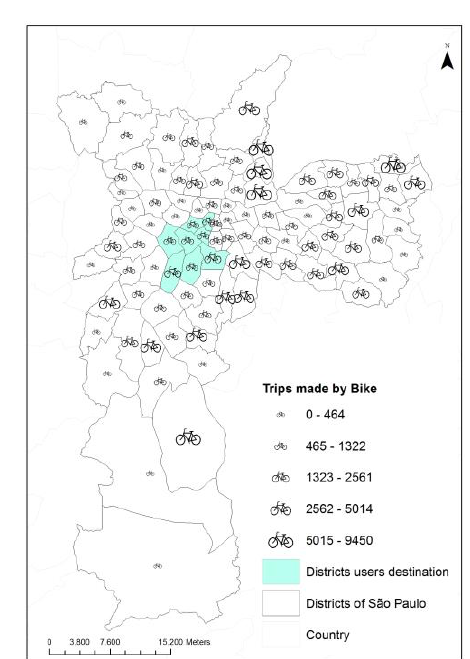
Figure 8. Number of trips: bicycle (Source: Authors)